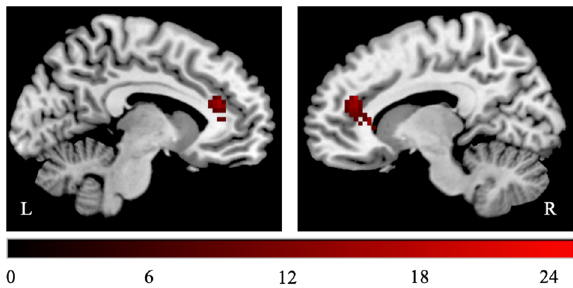
Fig. 3 Activation cluster for the interaction effect between EXPERTISE and CONGRUENCY depicted in the ch2better template in MRIcron107 at pFWE CLUSTER LEVEL < 0.05. L left, R